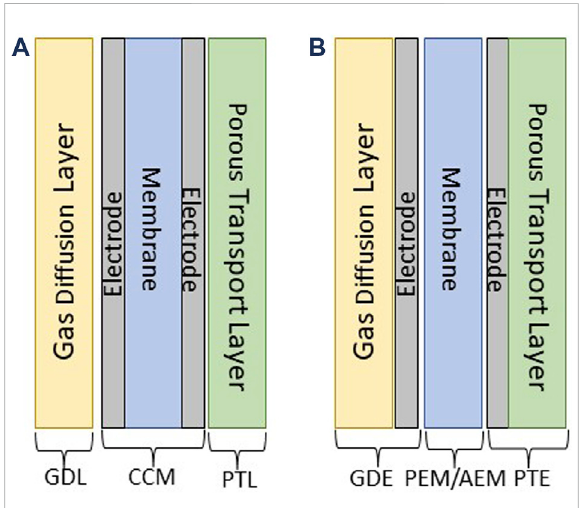
FIGURE 2 Illustrationof (A) GDL-CCM-PTLand (B) GDE-PEM/AEM-PTE con fi gurations